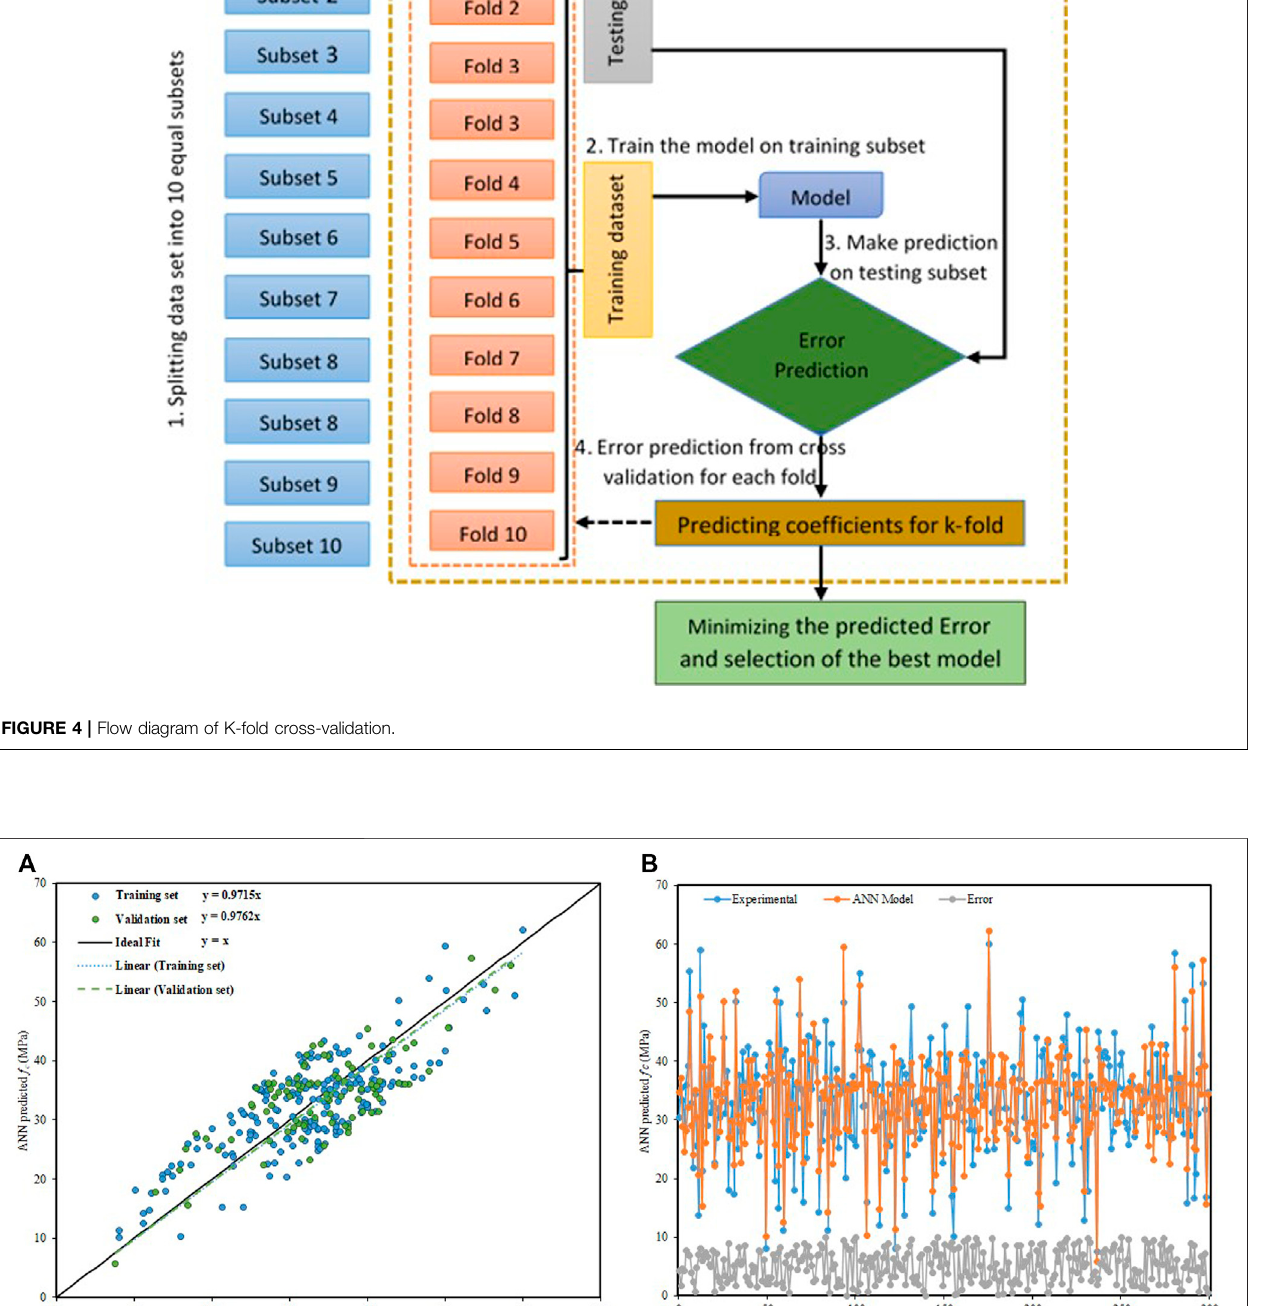
Frontiers in Materials |